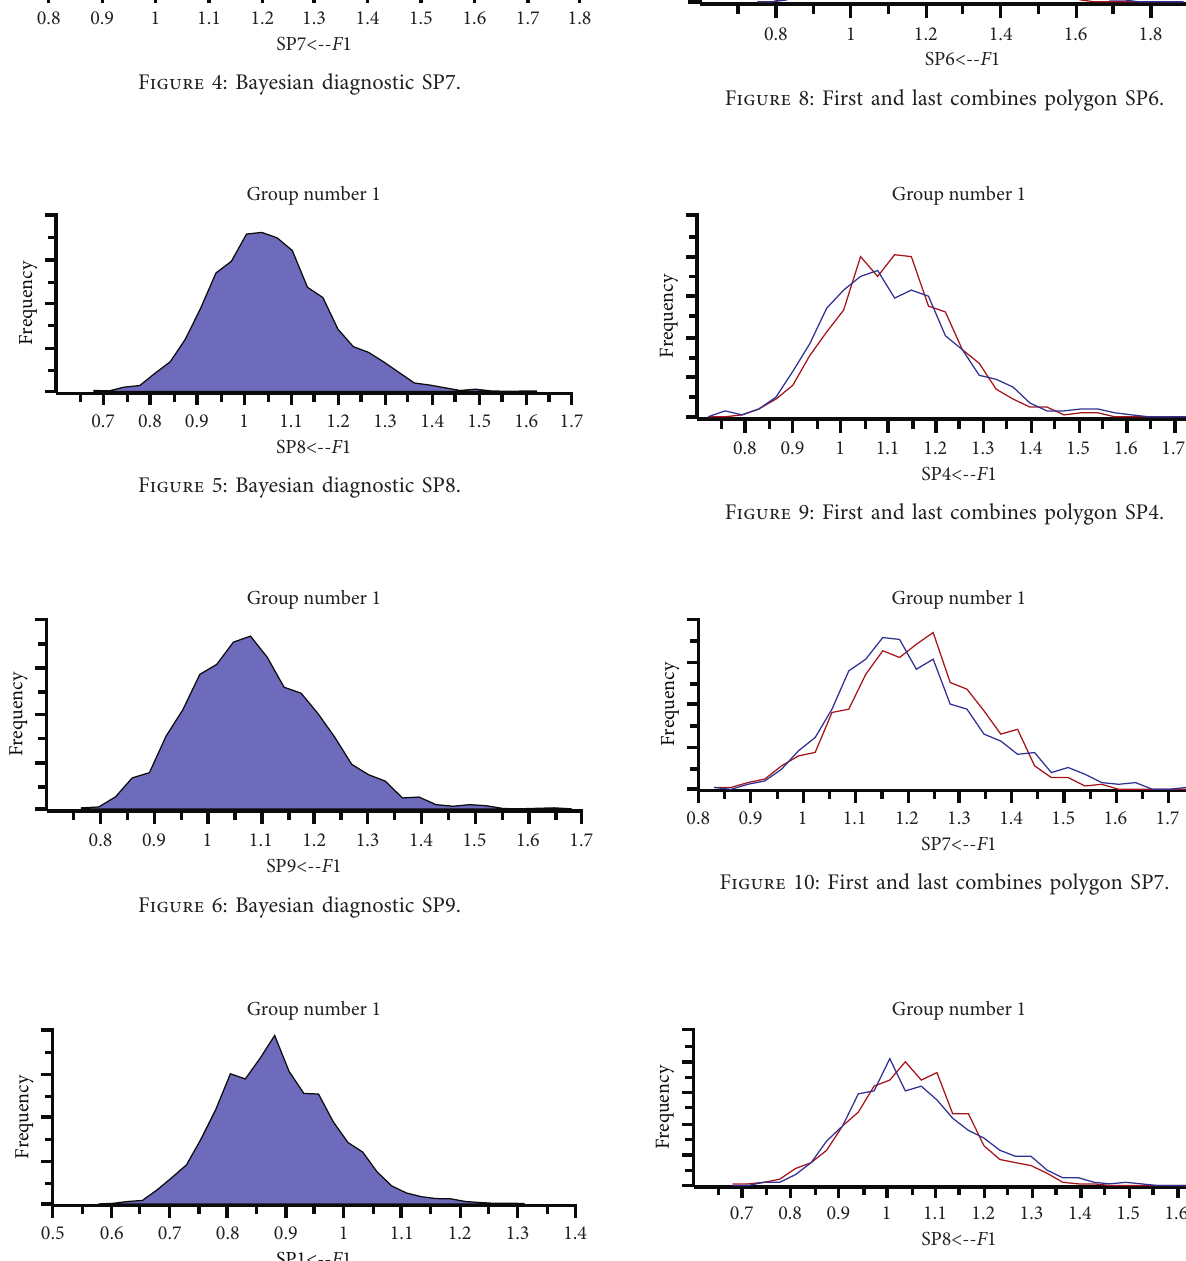
Figure 11: First and last combines polygon